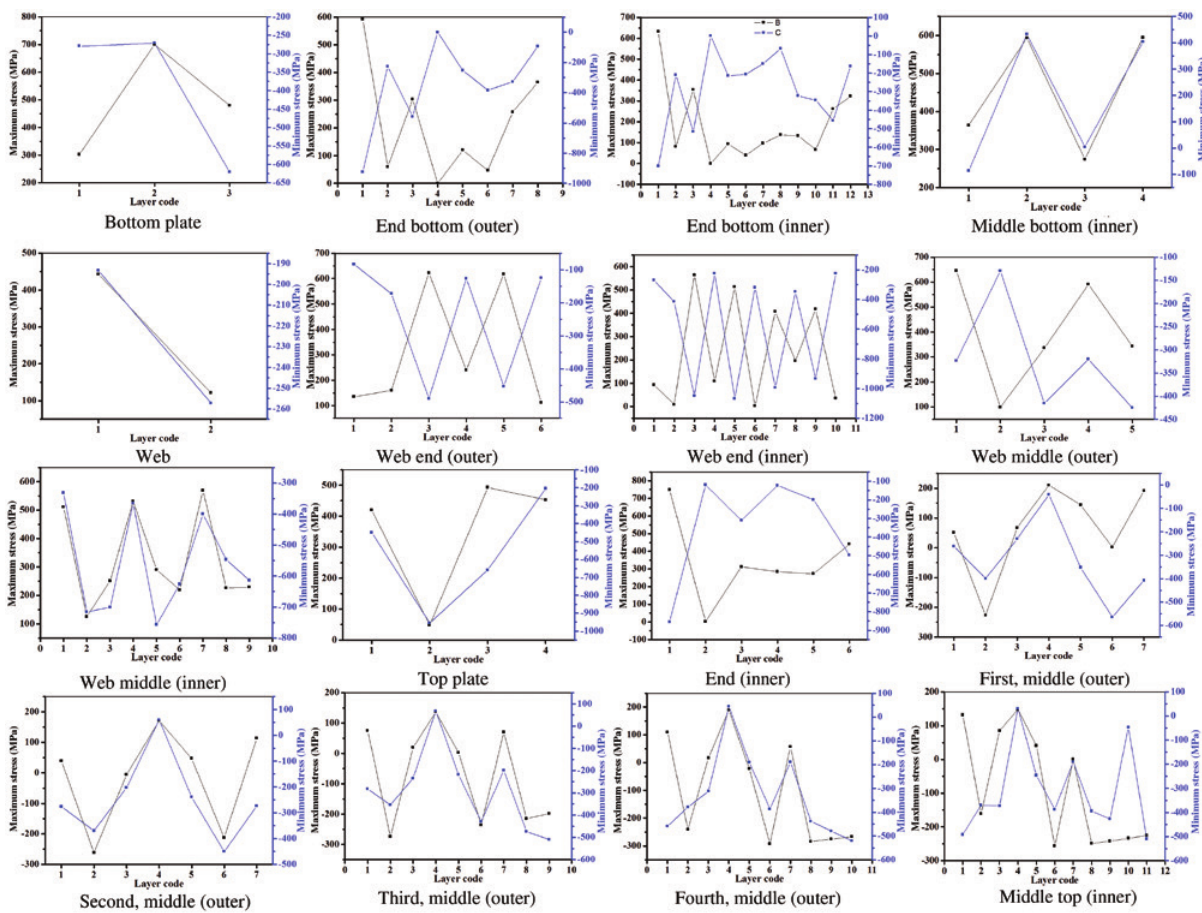
Figure 11: Maximum and minimum stress tendencies as a function of layer code in bottom, web and top plate and their stiffening